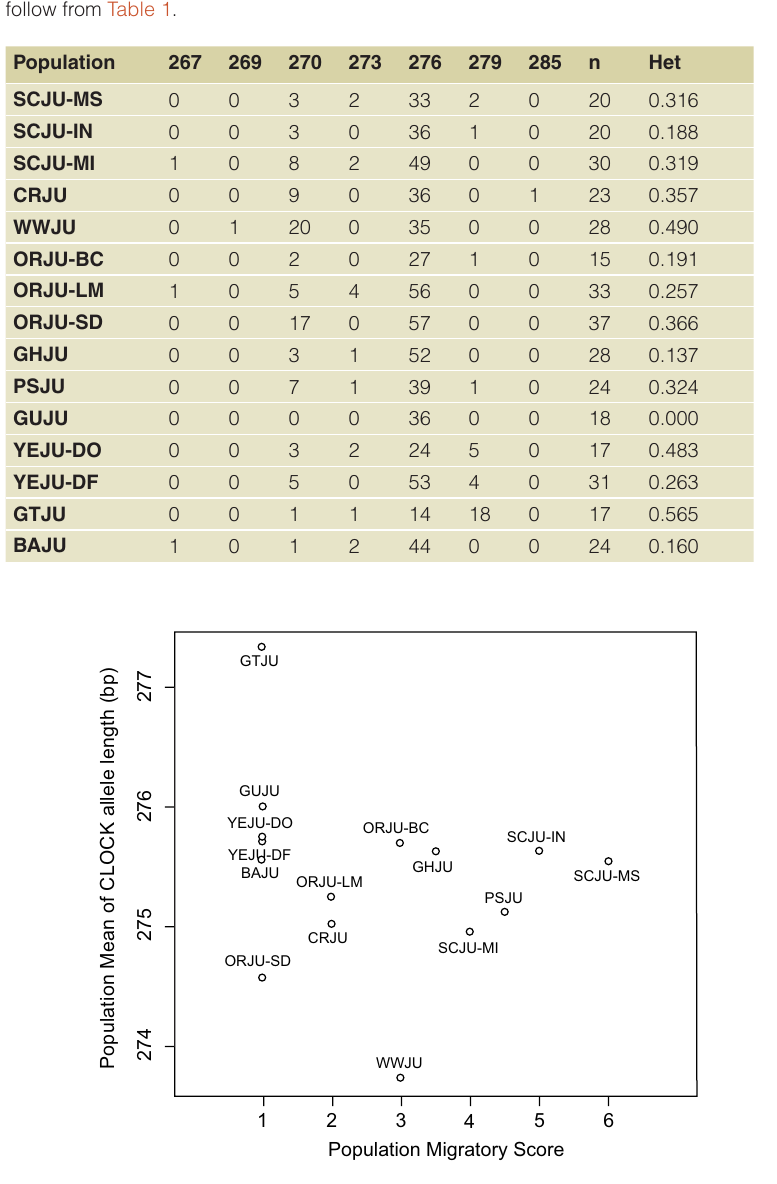
Figure 3. CLOCK allele length and migratory status. No correlation was found between population mean CLOCK allele length and migratory status (Spearman’s correlation, p >